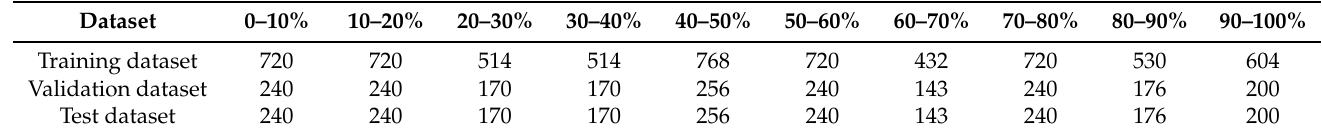
Table 2. Quantity of each type of